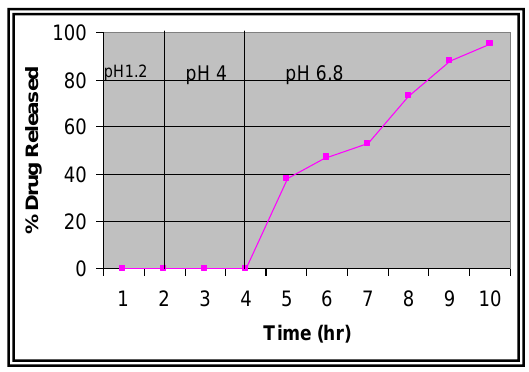
Figure 5 : The cumulative percent of